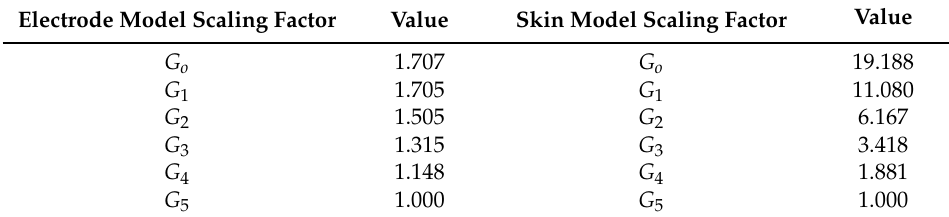
Table 7. Values of the scaling factors G j